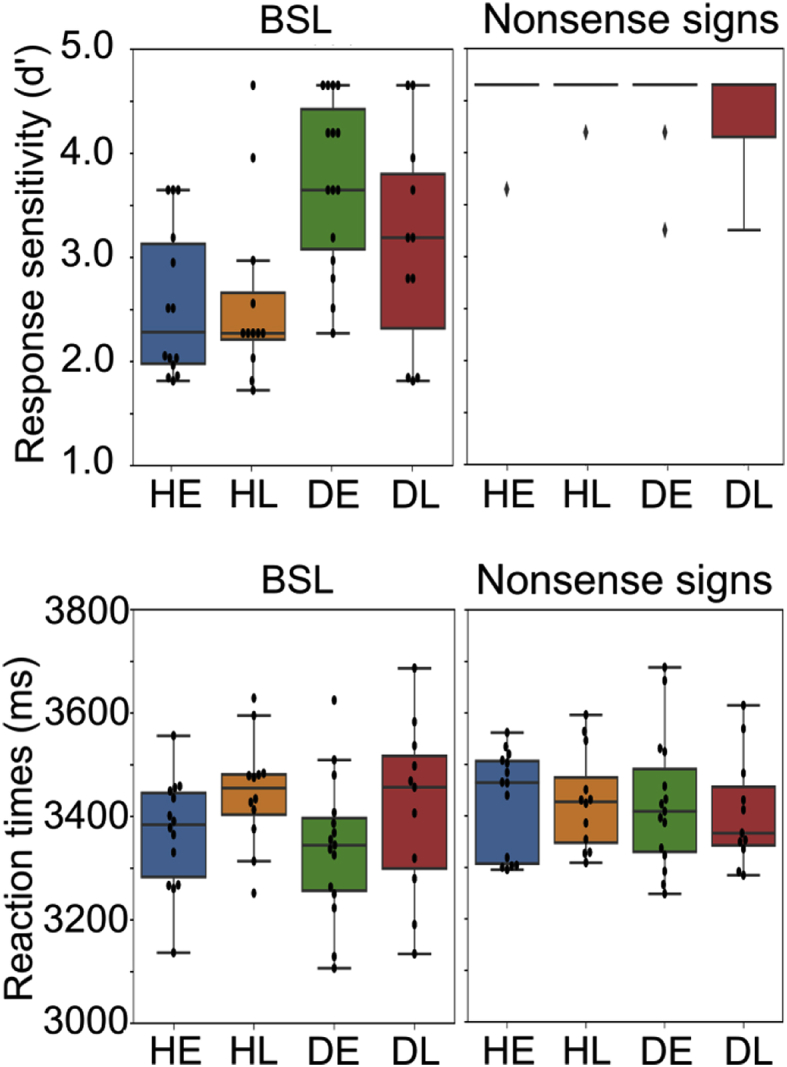
Behavioural data displayed as boxplots. Top row: response sensitivity (d’); BSL on the left, strings of nonsense signs on the right. Bottom row: reaction times (ms); BSL on the left, strings of nonsense signs on the right. Each data point is displayed as a black dot. Accuracy by all groups was at ceiling on the nonsense sign task and there were no significant effects of hearing status, age of BSL acquisition or interactions on reaction times. During the BSL task, response sensitivity was affected by hearing status (deaf ​> ​hearing) whilst reaction time was affected by age of BSL acquisition (early ​< ​late).